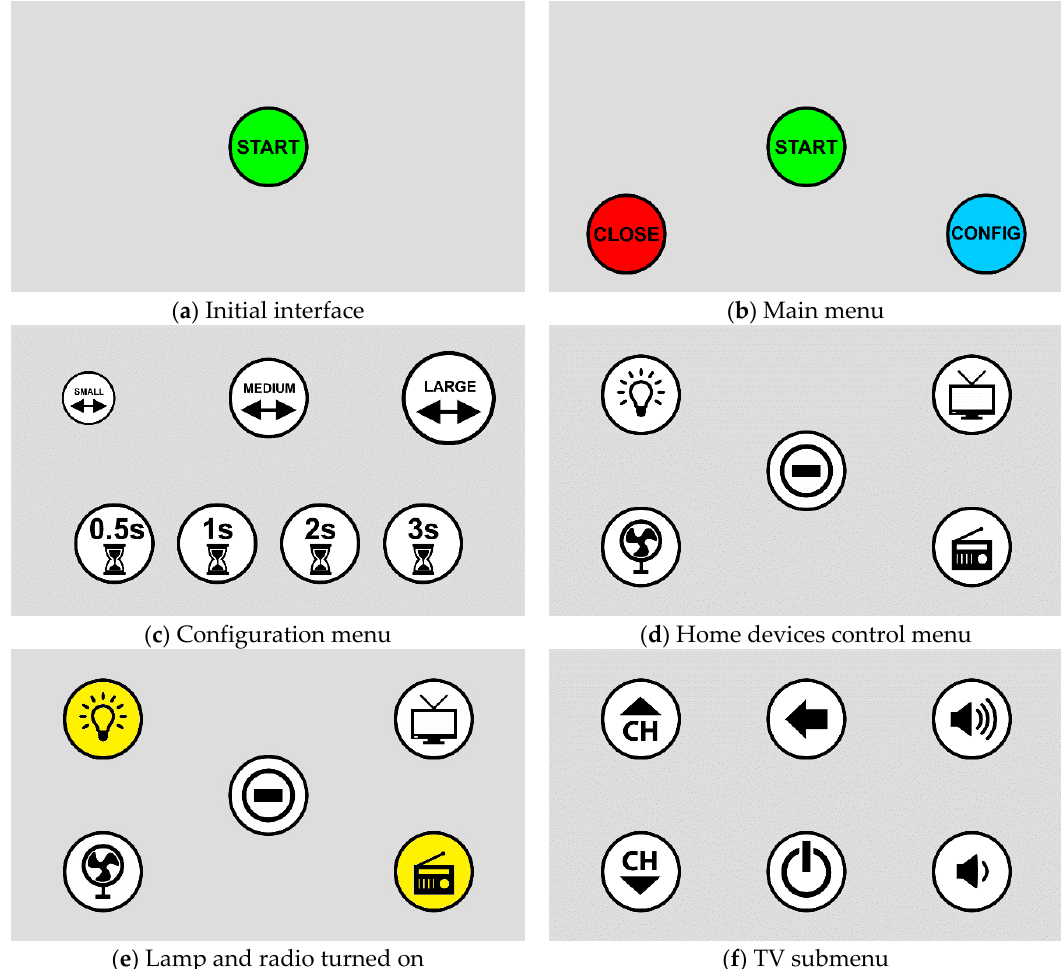
Figure 7. User interface.